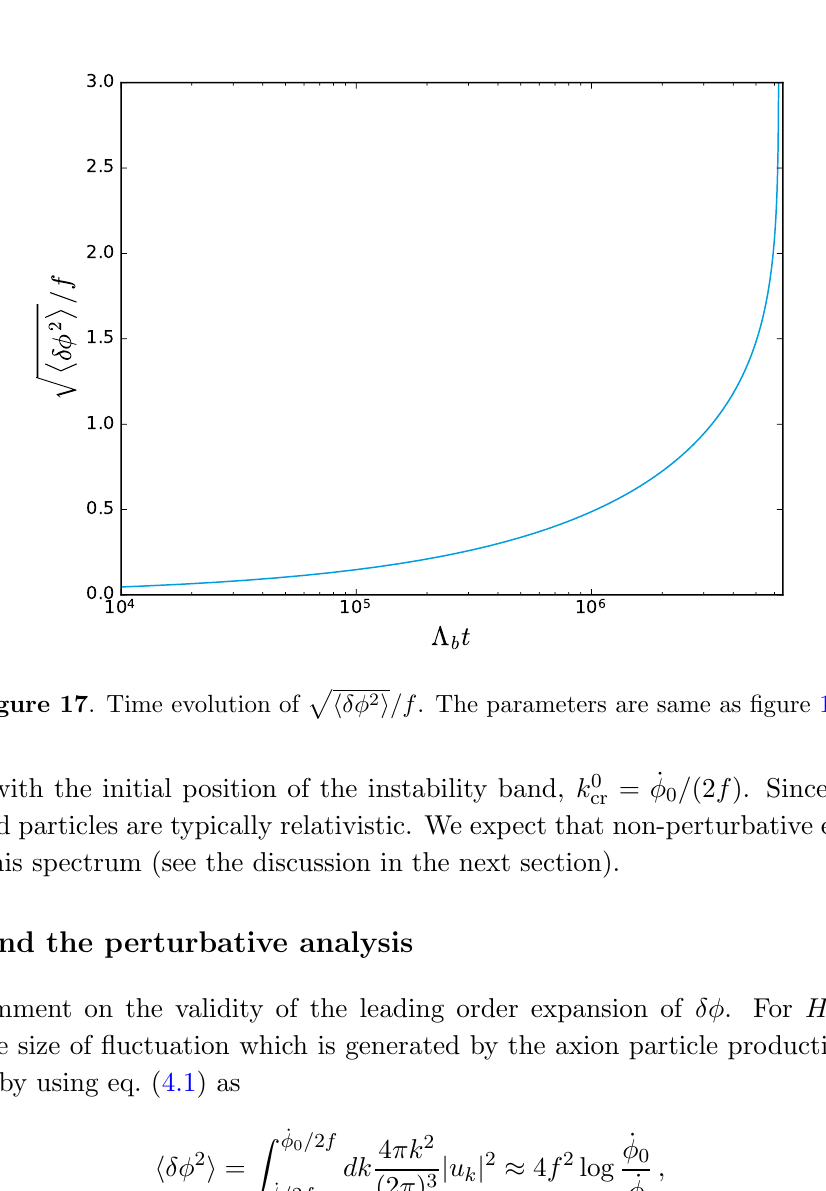
= _ (cid:30) = (2 f ). Since _ (cid:30) 0 cr